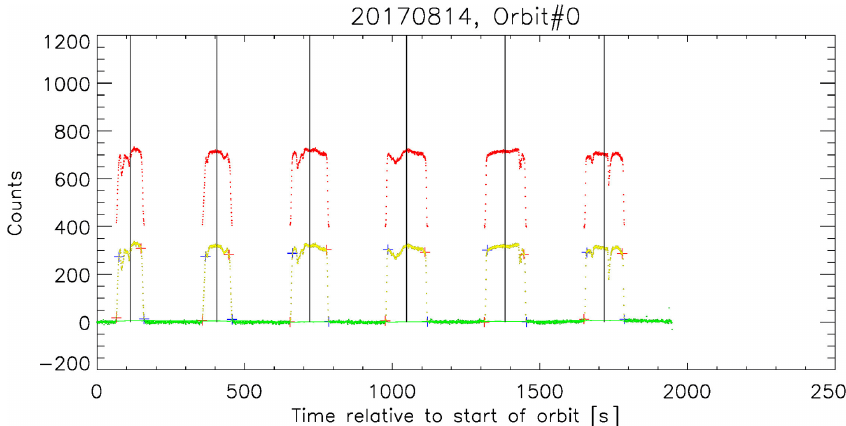
Figure 3. Further separation of space view (green) and Earth view (yellow) by detecting the jumping thresholds (blue and red crosses). After separating the views, C sp was further fitted again by a polynomial fitting to remove slowly varying component. The red dots (shifted upward by 200 counts) are the final Earth voltage counts that will be converted to TB. This final polynomial fitting seems redundant here for a good orbit but is quite necessary for a bad orbit, an example of which is given in Appendix B. The average time between the starting and ending times of each Earth-view spin is assigned as the nadir-view time (thin black vertical lines). Please note that the date format in this figure is year month